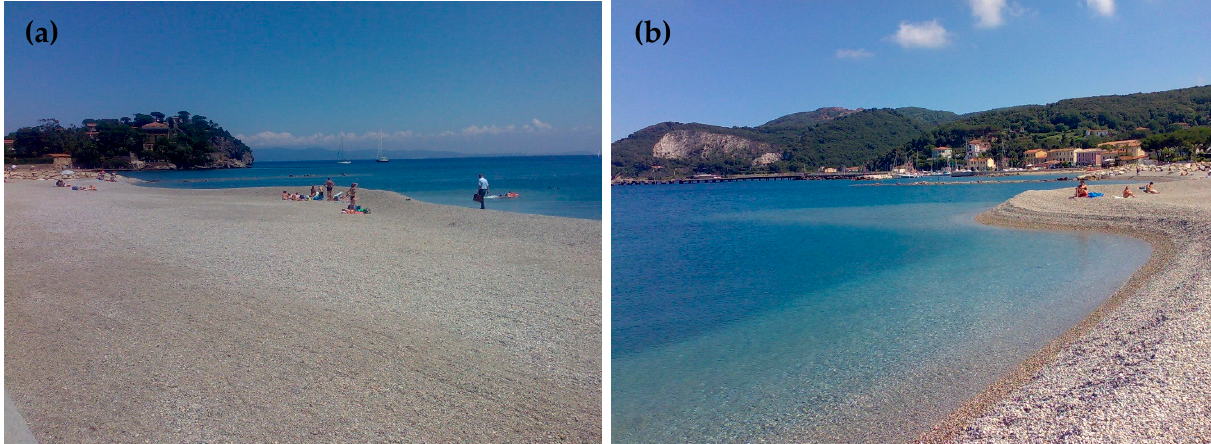
Figure 9. Northward ( a ) and southward ( b ) views of the remains of the filling groins on 18 June 2008.